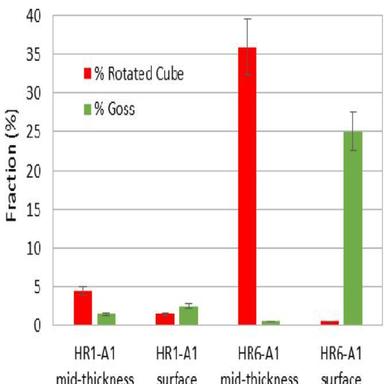
Texture heterogeneity through the thickness in the HR1 and HR6 samples after the first annealing A1. Rotated Cube and Goss fractions are measured at the midthickness and at the surface of the sheets.